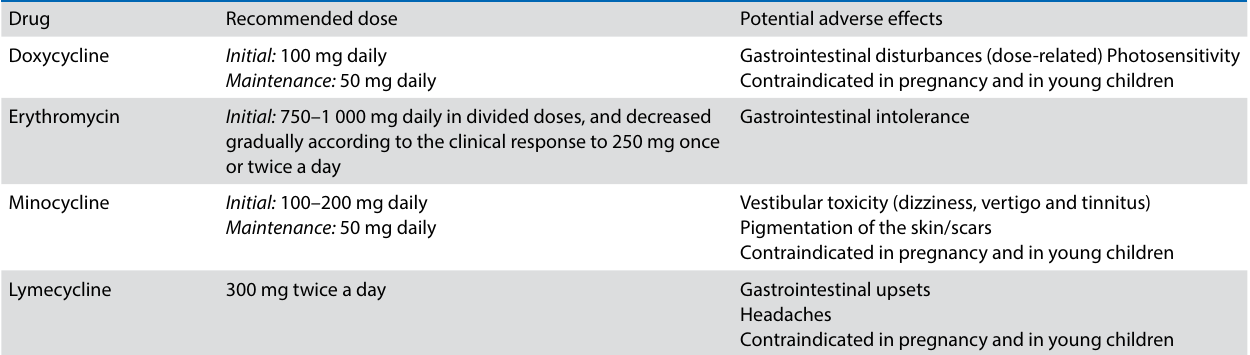
Table 3: Oral antibiotics used to treat acne vulgaris 3,6–8